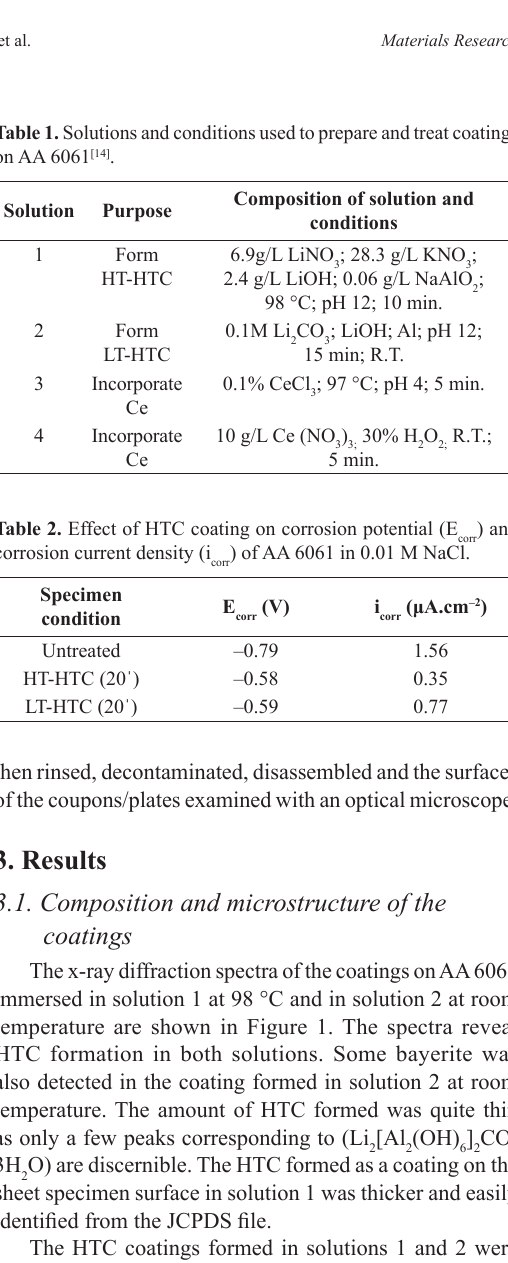
Table 1. Solutions and conditions used to prepare and treat coatings on AA 6061 [14] . Solution Purpose